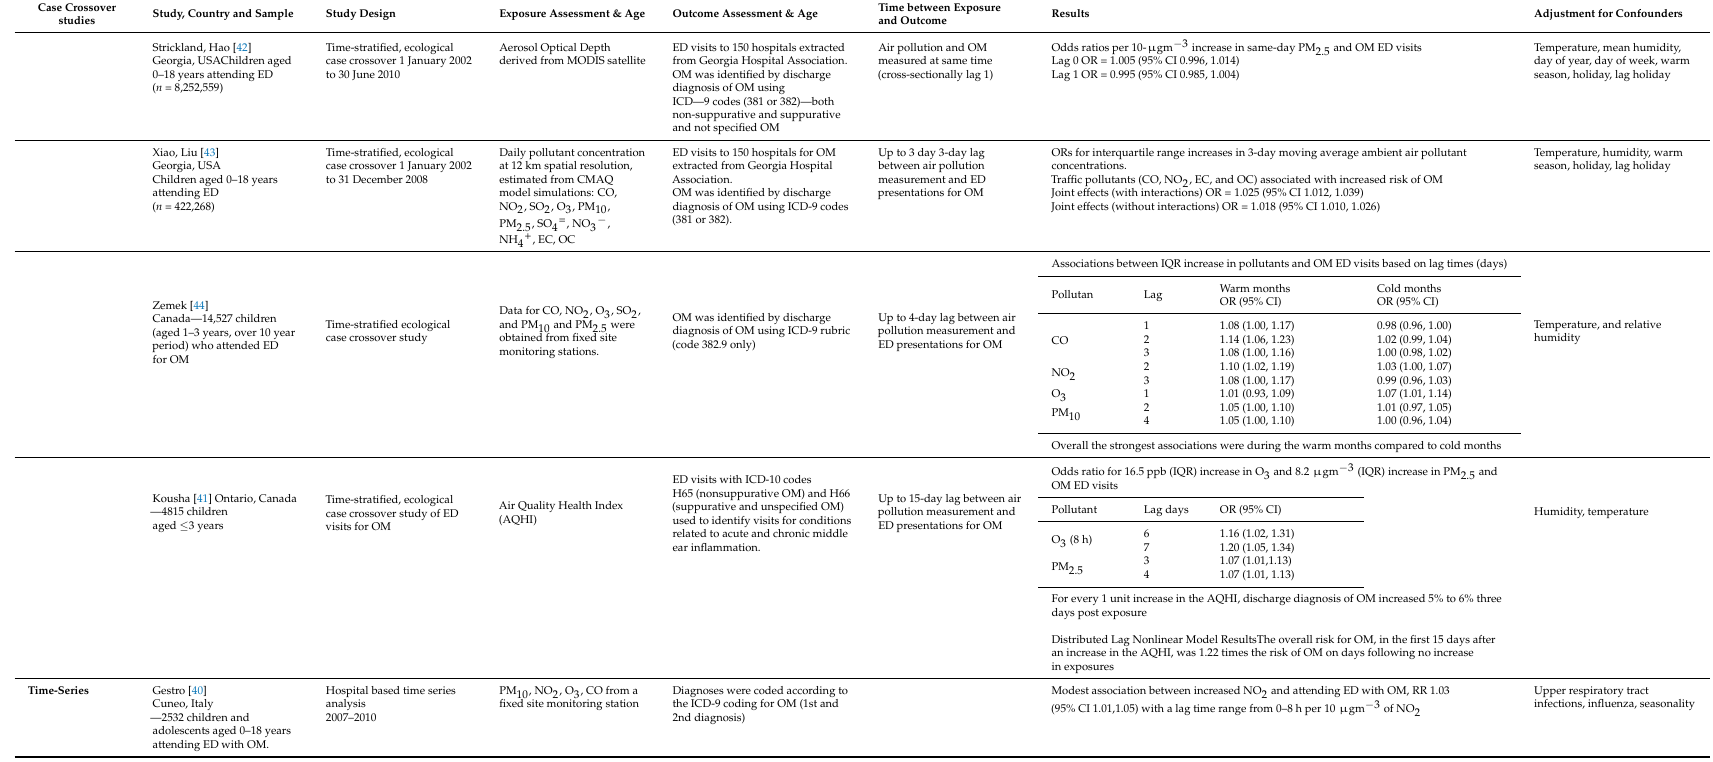
Table 2. Summary of air pollution exposure and otitis media in studies investigating lag